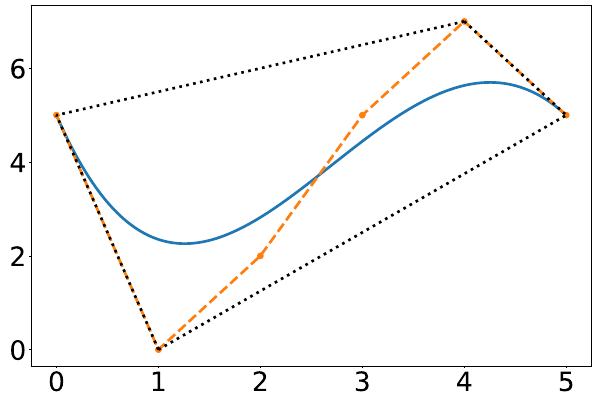
Figure A1. Convex hull of a Bernstein polynomial where the solid blue line is the curve, the black dotted line is the convex hull, and the orange points connected by dashed lines are the Bernstein